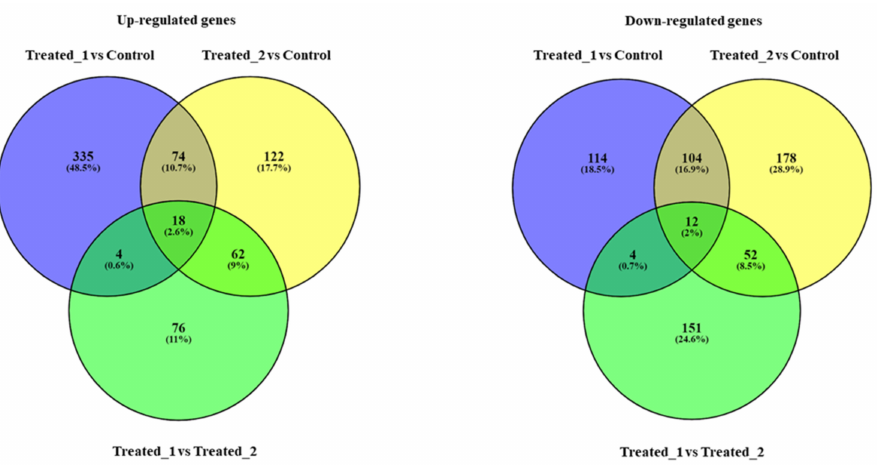
Figure 3. Venn diagrams considering up-regulated genes and down-regulated genes, comparing the groups “Treated_1 (plutei deriving from adults exposed for two months to sediment contaminated with PAHs) versus Control (plutei from adults sea urchin P. lividus reared for two months in tanks with sediment without contaminants)”, “Treated_2 (plutei deriving from adults exposed for two months to sediment contaminated with PCBSs) versus Control” and “Treated_1 versus Treated_2”. PAHs (Treated_1) and PCBs (Treated_2) induced an increase in the expression of 335 (48.5%) and 122 (17.7%) genes, respectively, compared to the Control; they also induced the down-regulation of 114 (18.5%) and 178 (28.9%) genes, respectively. The two contaminants had several common targets (see also Supplementary Tables S12 and S13 for the names of the common genes): (i) for up-regulated genes, 74 common genes (10.7%) comparing the groups “Treated_1 versus Control” and “Treated_2 versus Control”; 18 common genes (2.6%) comparing the groups “Treated_1 versus Control”, “Treated_2 versus Control” and “Treated_1 versus Treated_2”; 4 common genes (0.6%) comparing “Treated_1 versus Control” and “Treated_1 versus Treated_2”; 62 common genes (9.0%) comparing “Treated_2 versus Control” and “Treated_1 versus Treated_2”. (ii) for down-regulated genes, 104 common genes (16.9%) comparing the groups “Treated_1 versus Control” and “Treated_2 versus Control”; 12 common genes (2.0%) comparing the groups “Treated_1 versus Control”, “Treated_2 versus Control” and “Treated_1 versus Treated_2”; 4 common genes (0.7%) comparing “Treated_1 versus Control” and “Treated_1 versus Treated_2”; 52 common genes (8.5%) comparing “Treated_2 versus Control” and “Treated_1 versus